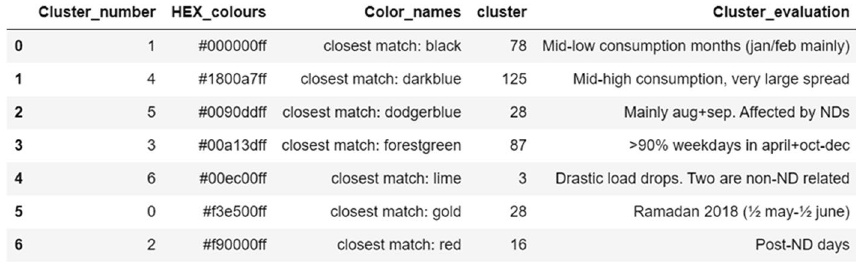
Fig. 24 The dataframe for the seven clusters of Lombok electricity consumption in 2018